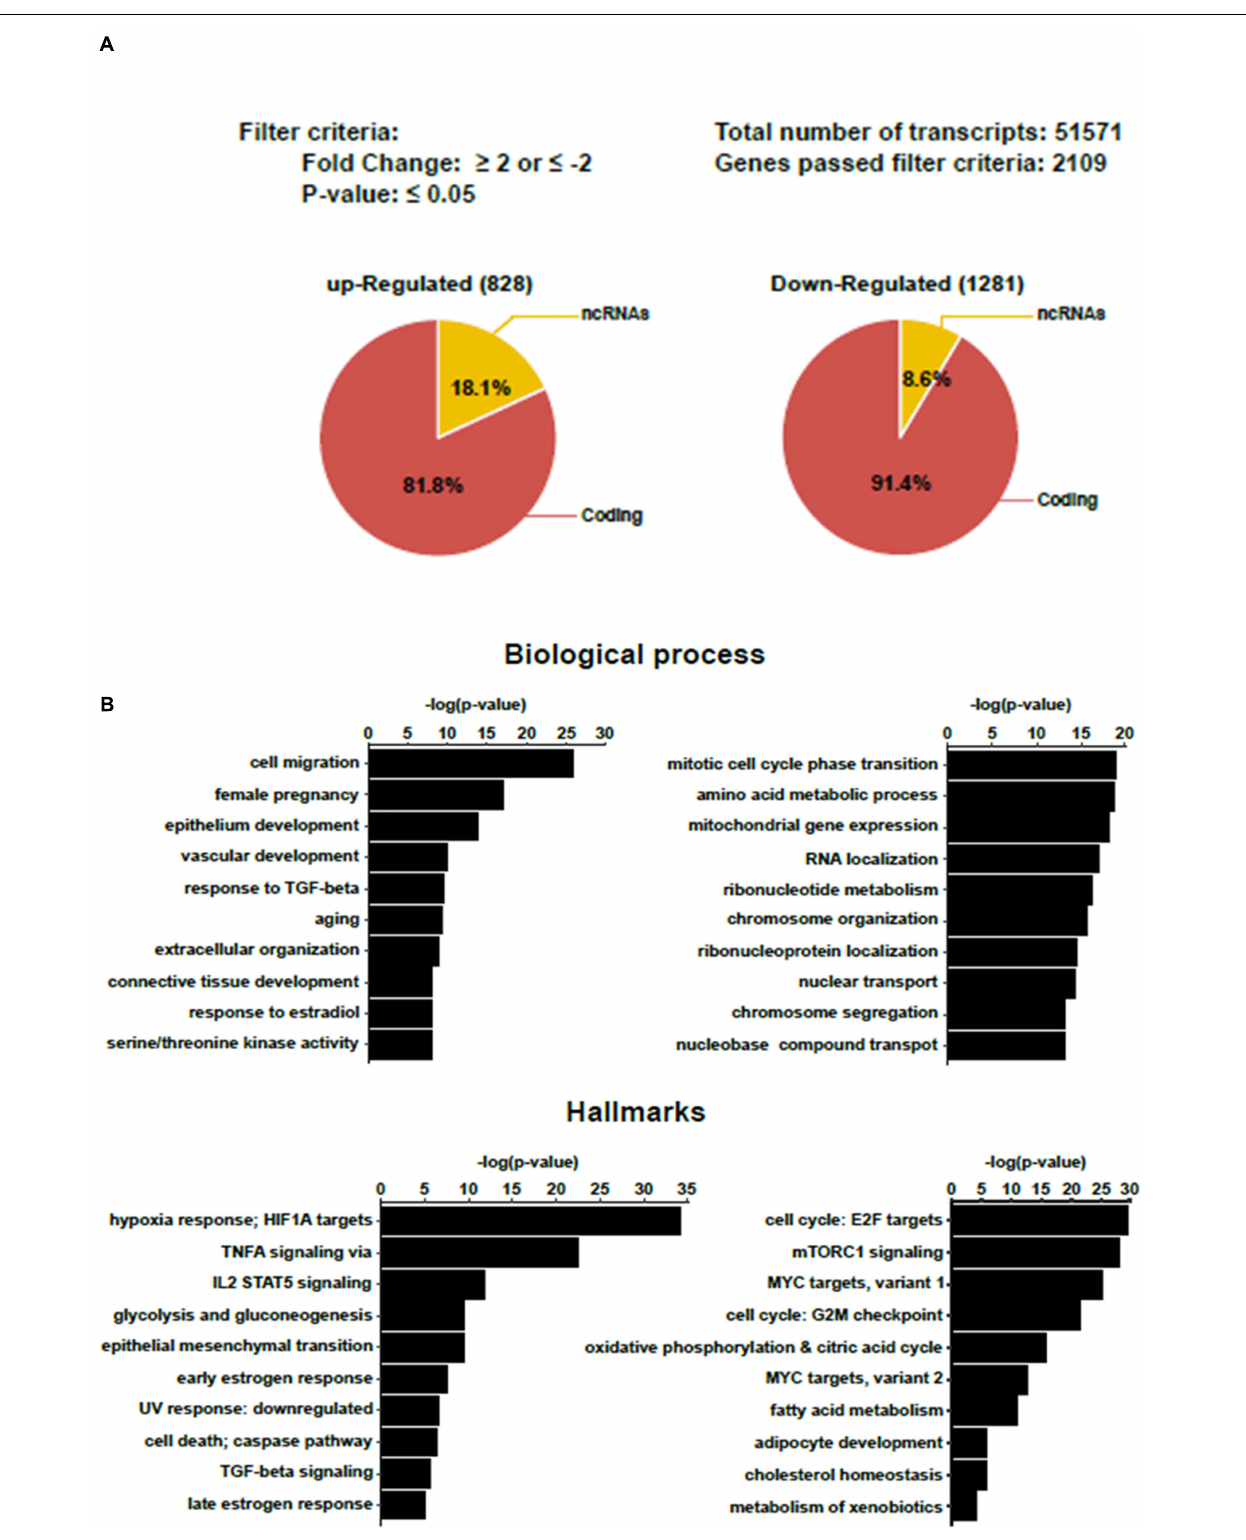
FIGURE 2 | Transcriptomic analysis of BeWo cells after 72 h treatment with forskolin. (A) Summary of transcriptomic analysis. Genes with a fold change (FC) either ≤ -2 or ≥ 2, and P ≤ 0.05 were considered differentially expressed in the BeWo cells treated with forskolin (BeWo-FSK) relative to the untreated cells (BeWo-CO). (B) Over Representation Analyis (ORA) showing principal Biological processes and Hallmarks enriched by the up-regulated (left) and down-regulated (right) DEGs in the BeWo-FSK compared to the BeWo-CO.